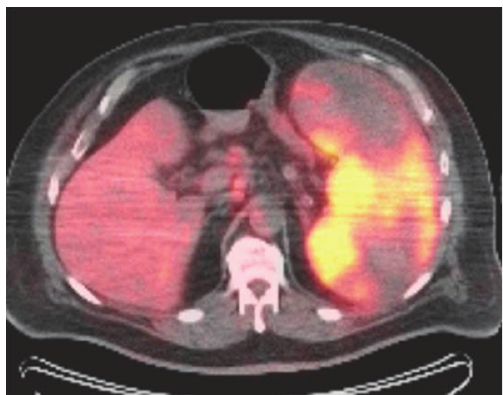
Figure 4: Axial PET CT image showing FDG uptake in the lesions suggestive of high metabolic